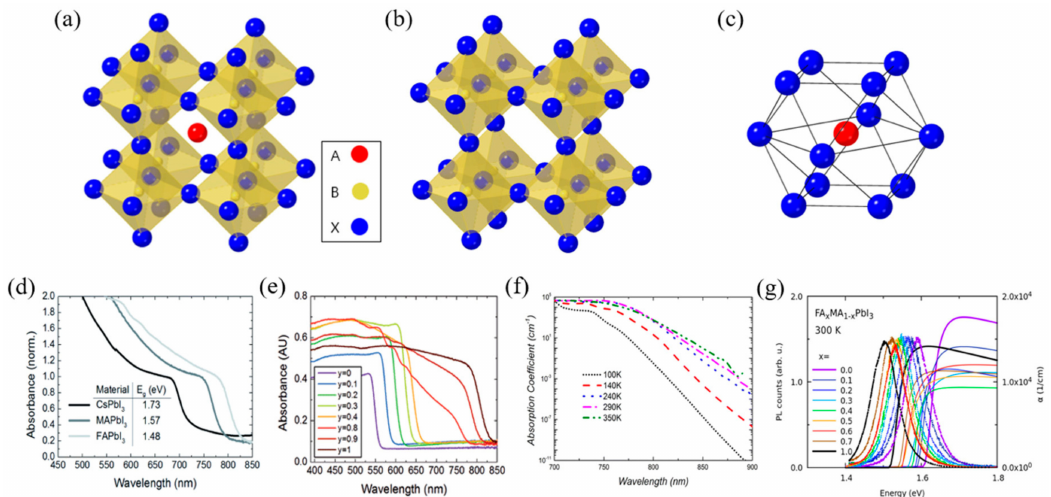
Figure 1. Intrinsic crystal structure and optical properties of perovskite materials. ( a ) A typical perovskite crystal structure. ( b ) Crystal structure of B cation and X anion (B cation is located at the octahedral site of X anion). ( c ) Crystal structure of A cation and X anion (A cation is located at the octahedron site of X anion. ( d ) UV-vis spectra for the APbI 3 perovskites formed, where A is either cesium (Cs), methylammonium (MA) or formamidinium (FA). ( e ) UV-vis absorption spectra FAPbI y Br 3-y perovskites. ( f ) Temperature dependence of the absorption coe ffi cient of methylammonium lead iodide (MAPbI 3 ) extracted from photoluminescence (PL) spectra. ( g ) Near-bandgap absorption and photoluminescence spectra at room temperature mixed-organic perovskites